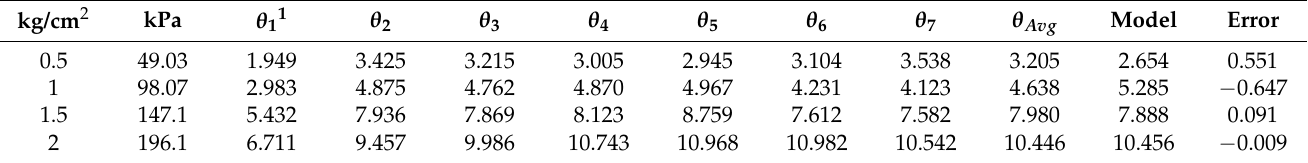
Table 2. Comparison between measured angles and mathematical model’s results